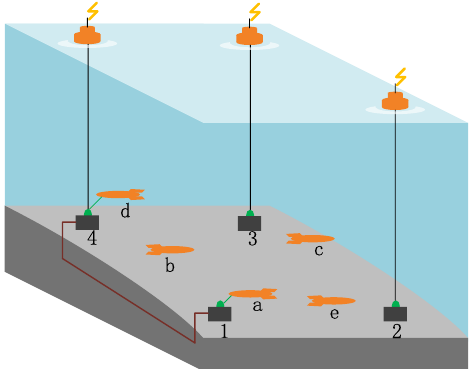
Figure 1. The system consists of underwater robots and communication nodes. In addition, 1 – 4 are communication nodes that have already been deployed into the AOI. Nodes 1 and 4 are connected with an underwater cable while the rest nodes are connected to buoys equipped with antennas so that they can communicate via radio signals. a – e are underwater robots equipped with an optical communication device, enabling them to exchange data with the communication network when visiting a communication node. In the figure, robot a is communicating with communication node 1, and robot d is communicating with communication node 4. Other robots, i.e., robots b , c and e are searching. The relationship between robots and nodes is not one-to-one, and one robot can visit any